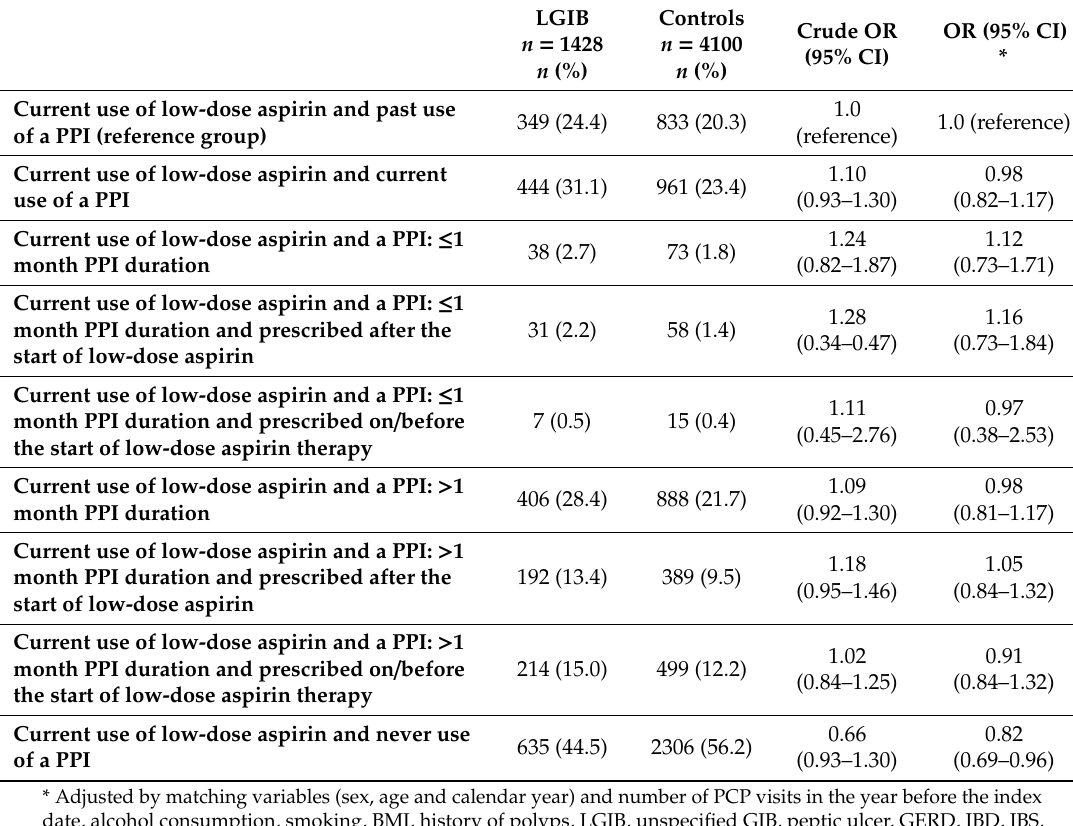
Table 3. ORs (95 CIs) for the association between concomitant use of low-dose aspirin and a PPI and the risk of